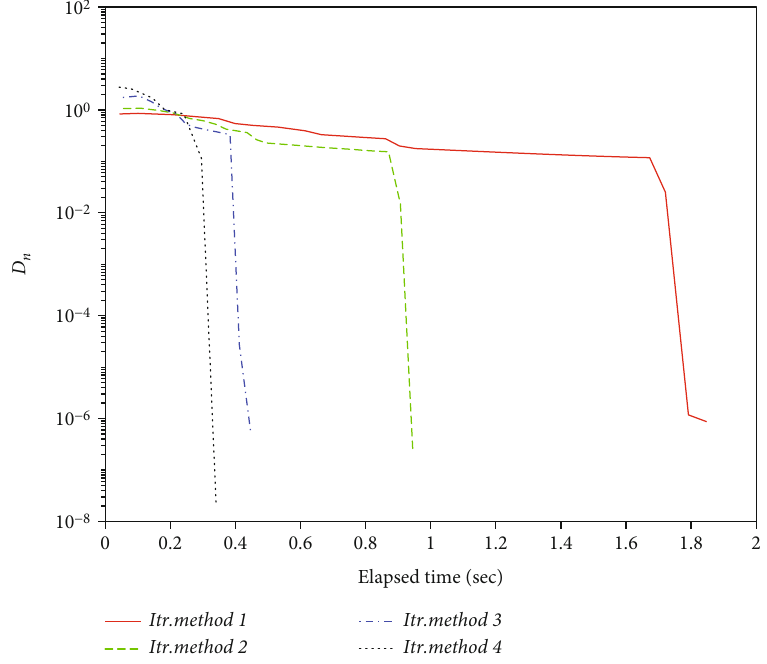
Figure 12: All methods are compared computationally while x